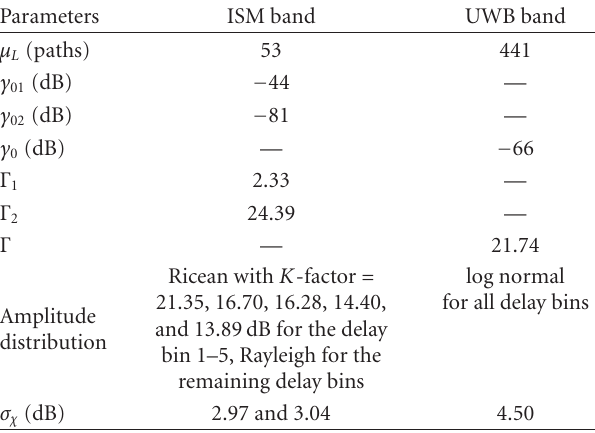
Table 3: Channel parameters for simulation for the case of Rx 17